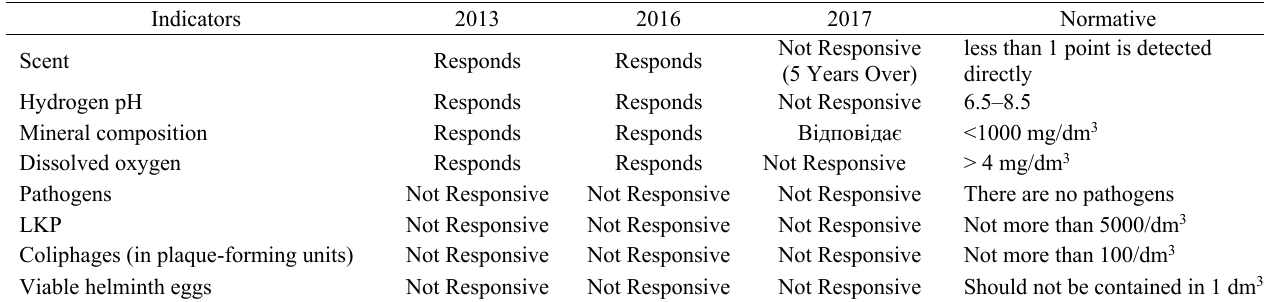
Characteristics of surface waters of the Basov Kut reservoir